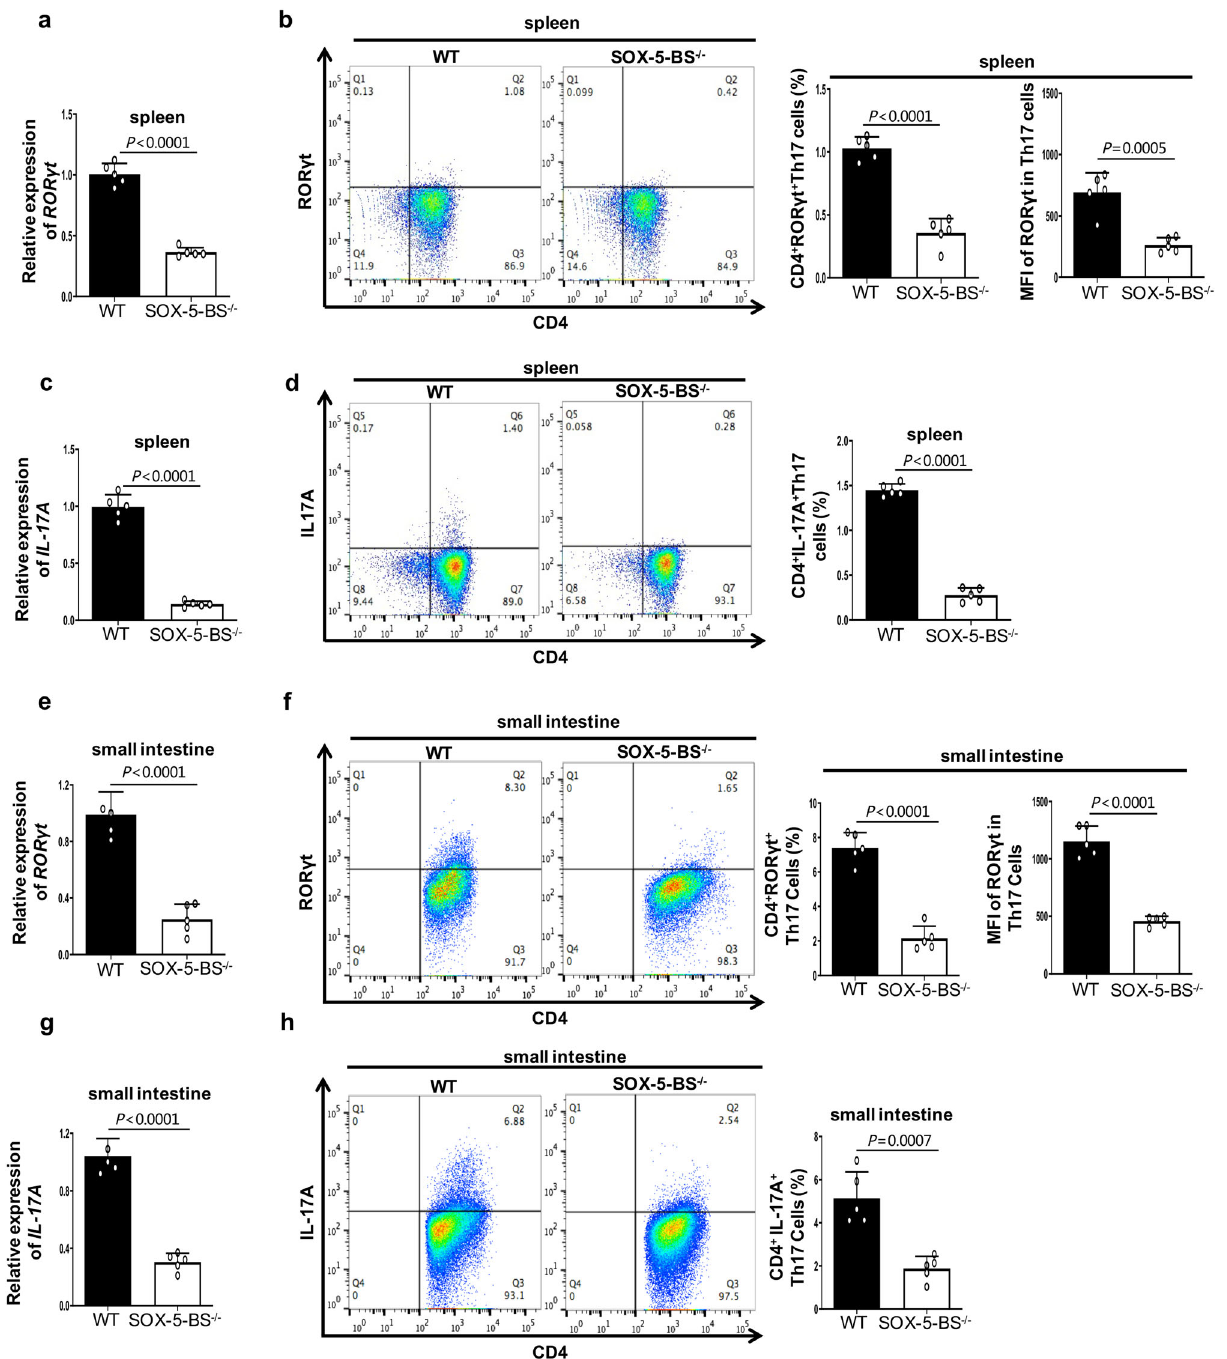
Fig. 7 SOX-5-BS deletion in RORCE results in reductions in ROR γ t expression and Th17 cell numbers in vivo. a Relative mRNA expression of ROR γ t gene in splenic CD4 + T cells from indicated mice. b Frequencies of CD4 + ROR γ t + Th17 cells in splenic CD4 + T cells from indicated mice. The MFI of ROR γ t in Th17 cells was also analyzed and summarized. c Relative mRNA expression of IL-17A gene in splenic CD4 + T cells from indicated mice. d Frequencies of CD4 + IL-17A + Th17 cells in splenic CD4 + T cells from indicatded mice. e Relative mRNA expressions of ROR γ t gene in LP CD4 + T cells from the small intestine of indicated mice. f ROR γ t + Th17 frequencies in CD4 + CD45 + Lin + lymphocyte population and MFI of ROR γ t in Th17 cells from LP of small intestine of indicated mice. g Relative mRNA expressions of IL-17A gene in LP CD4 + T cells from the small intestine of indicated mice. h IL-17A + Th17 frequencies in CD4 + CD45 + Lin + lymphocyte population from LP of small intestine of indicated mice. Mean ± SEM are shown, n = 5 independent experiments, unpaired two-tailed Student ’ s t -test ( a – h ). Experimental mice were between 8 and 12 weeks of age, with no preference to gender and were maintained on a C57BL/6 background. Source data are provided as a Source Data fi le.